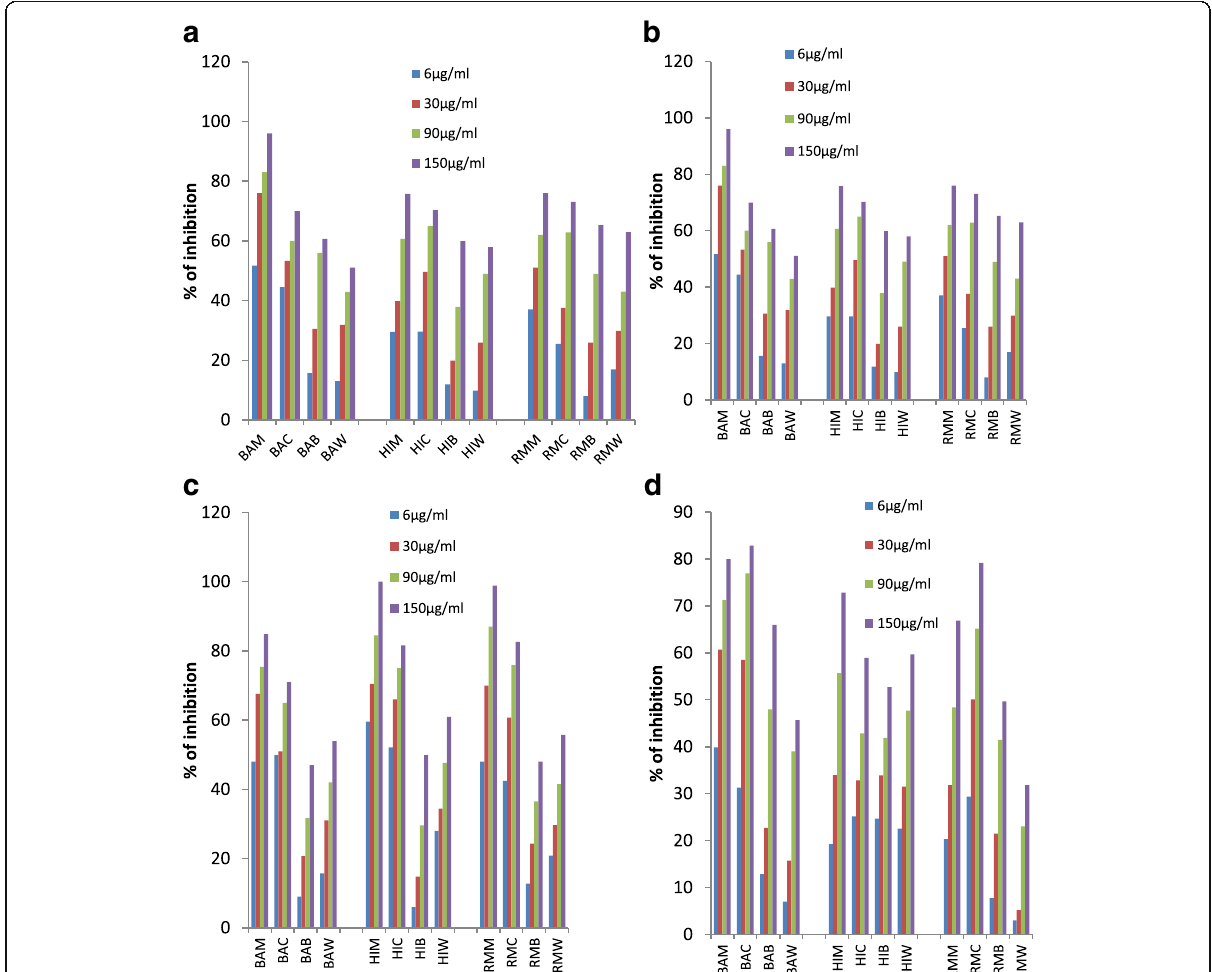
Fig. 1 Does dependent inhibitory activity of plant methanolic extracts and its derived fractions against a AChE; b BuChE; c α – Glucosidase; d β –